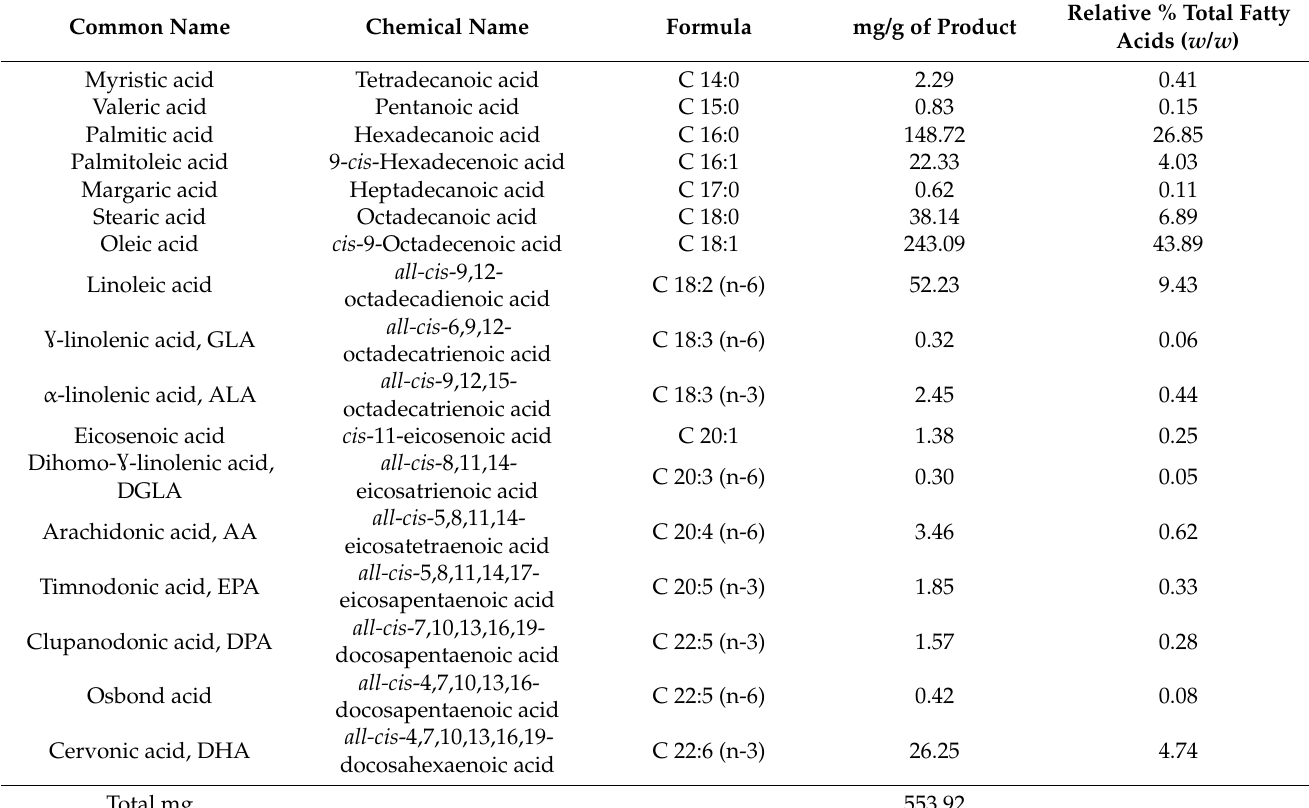
Table 1. OVO-DHA ® fatty acid composition. Source: ASL (Vichy, France).